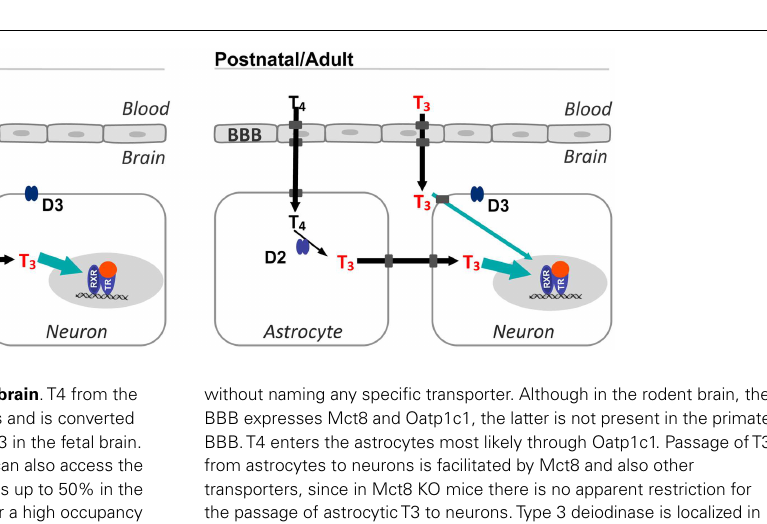
FIGURE 1 | Sources ofT3 in the fetal and postnatal brain .T4 from the circulation crosses the BBB and reaches the astrocytes and is converted toT3 by type 2 deiodinase.This is the main source ofT3 in the fetal brain. In postnatal and adult animals,T3 from the circulation can also access the brain.The proportion ofT3 from the circulation increases up to 50% in the late postnatal stages. In situ T3 production accounts for a high occupancy of thyroid hormone receptors (green arrow), and is also important for expression of genes regulated negatively by thyroid hormone. Transporters in the cell membranes are represented by gray squares,